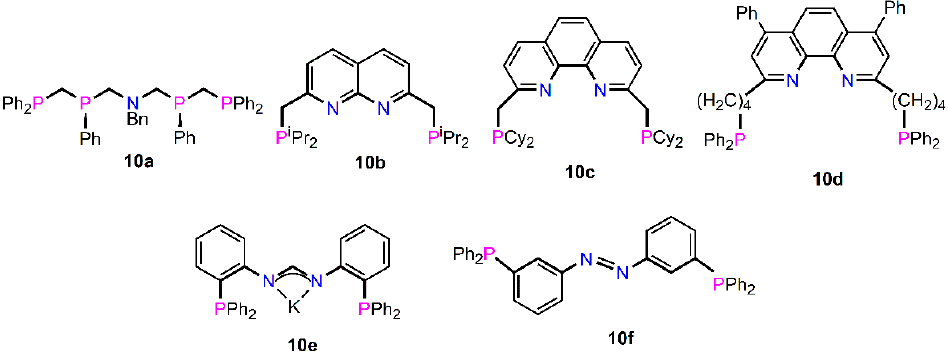
Figure 14. Selected examples of P–C–P–C–N–C–P–C–P, P–C m –N–C n –N–C m –P and P–C 3 –N–N–C 3 –P ligands ( m = 2,5; n = 1,2).